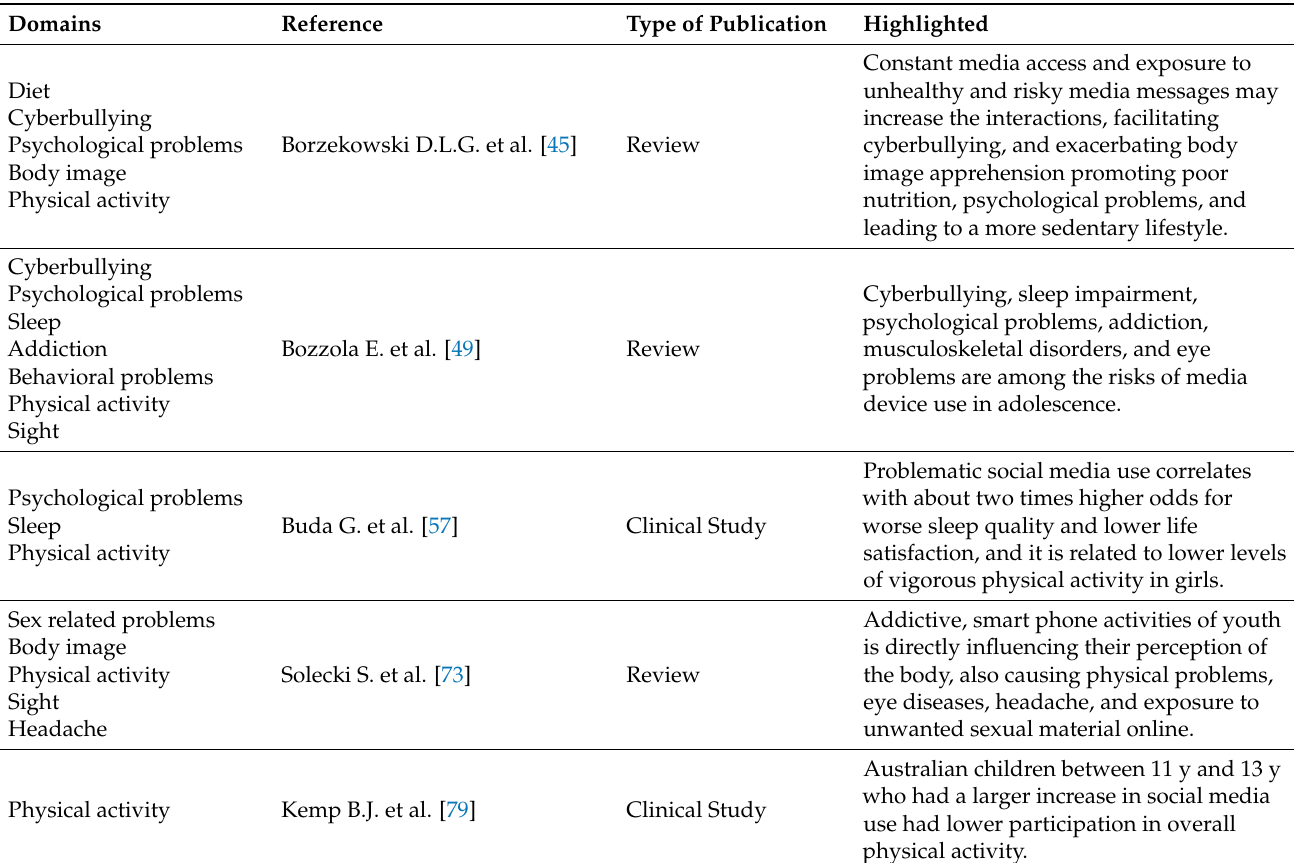
Table 12. Social media and physical